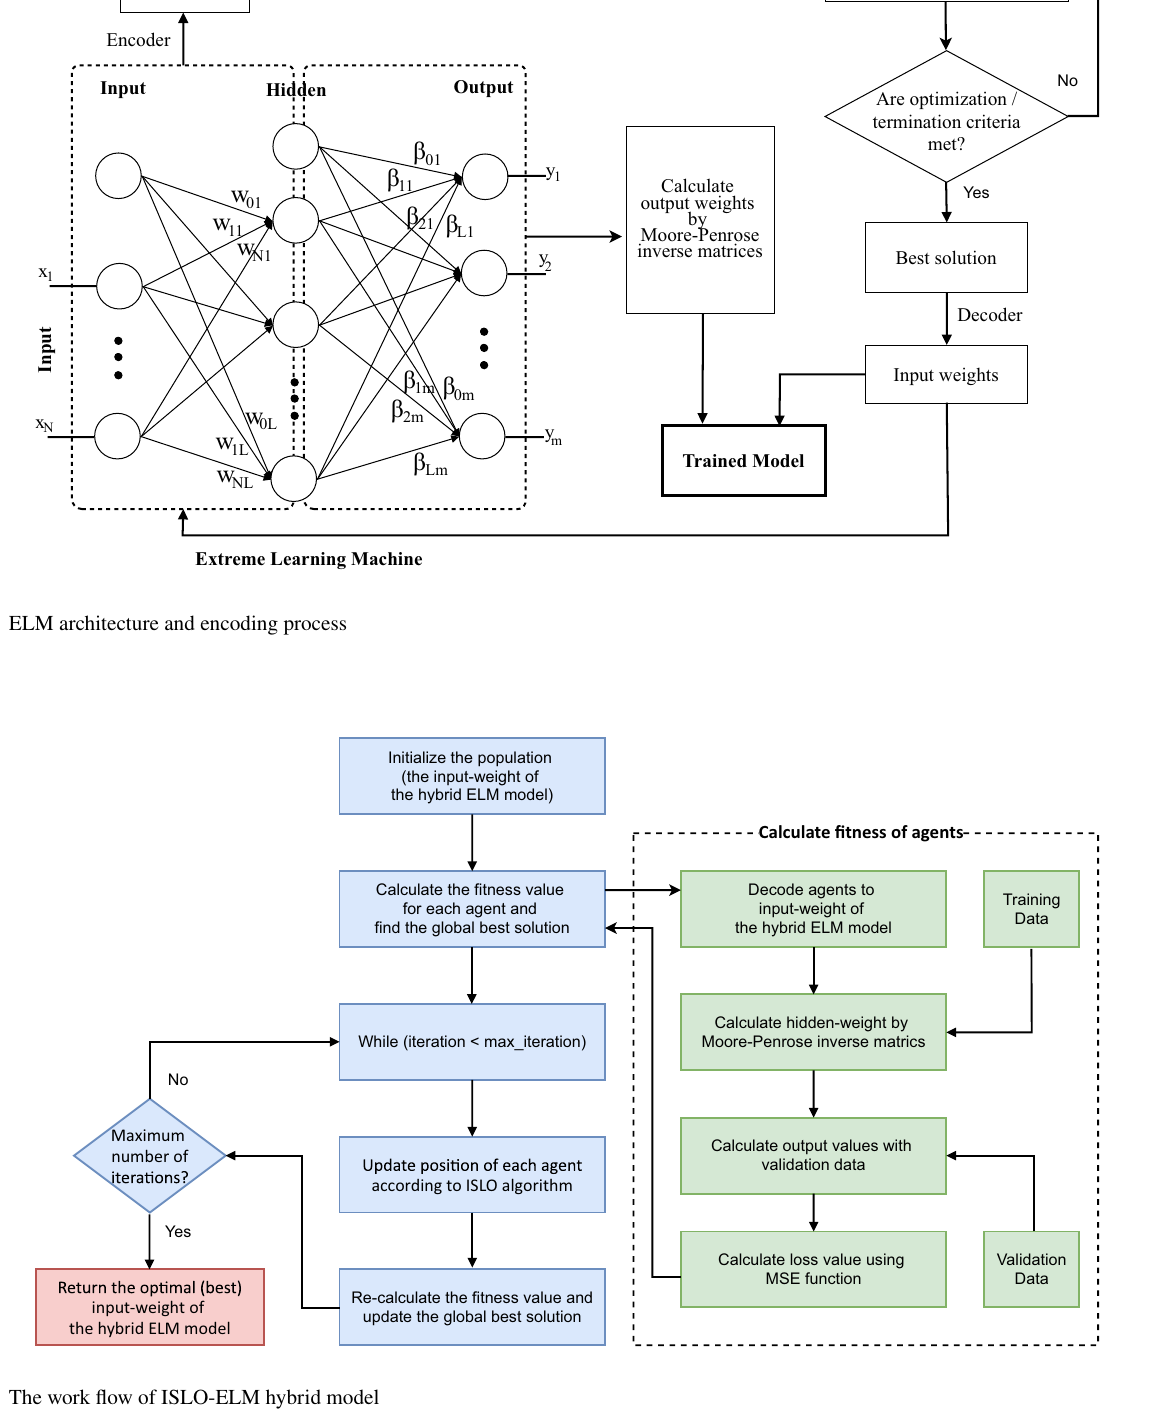
Fig. 3 The work flow of ISLO-ELM hybrid